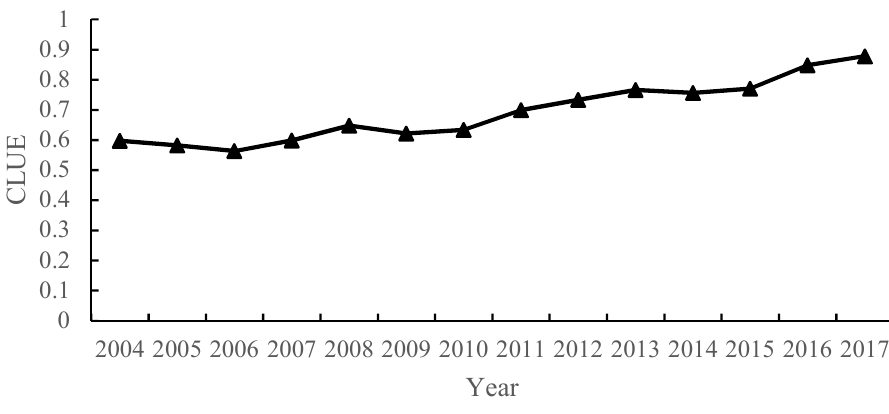
Figure 3. The changing trend of CLUE.